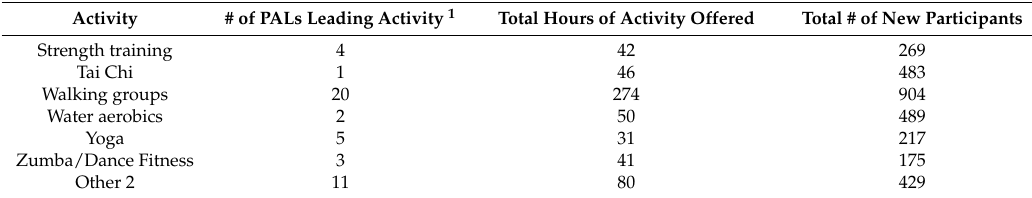
Table 1. PAL intervention activities, July 2017–Feb